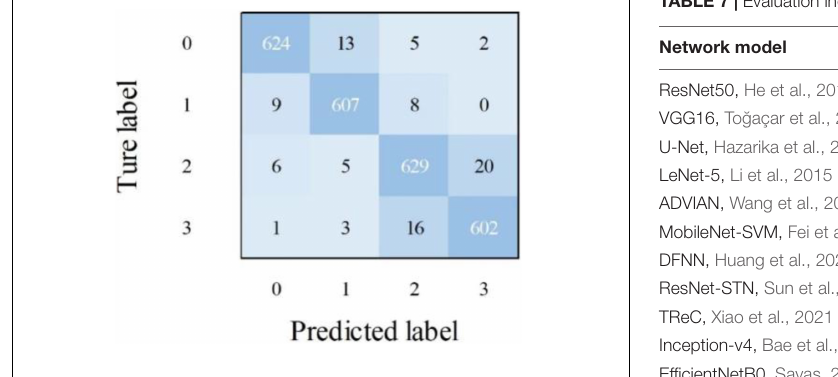
FIGURE 2 | Confusion matrix of the MPC-STANet.